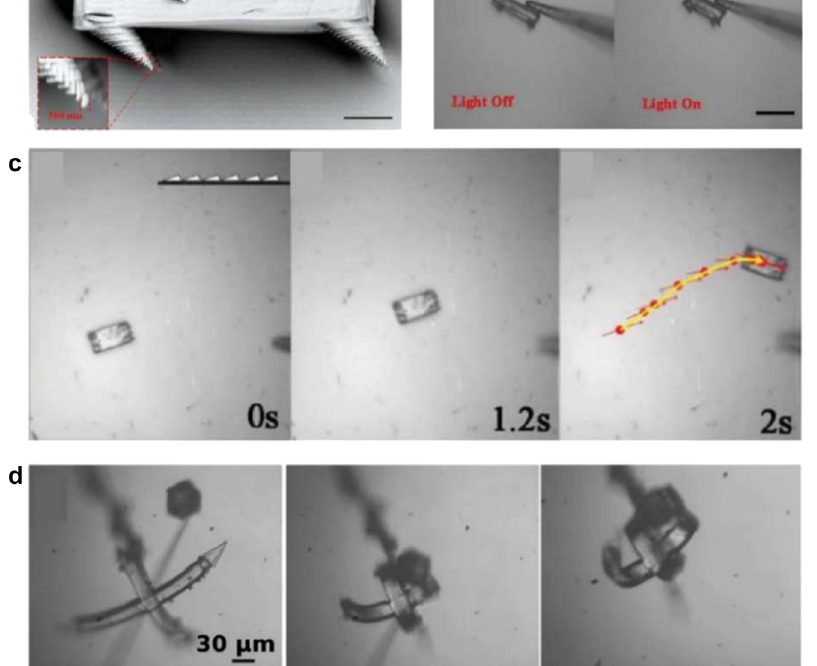
Figure 12: DLW of light-driven